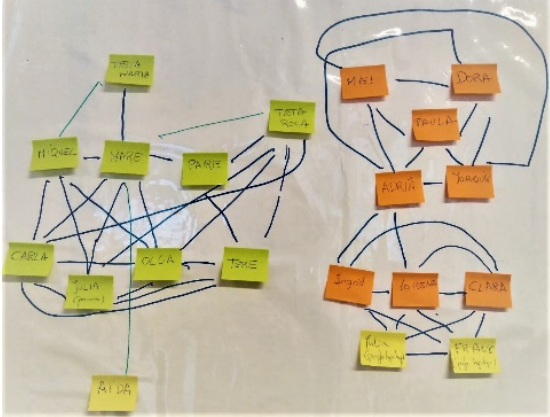
Figure 2. Handmade personal network (alters relationships).